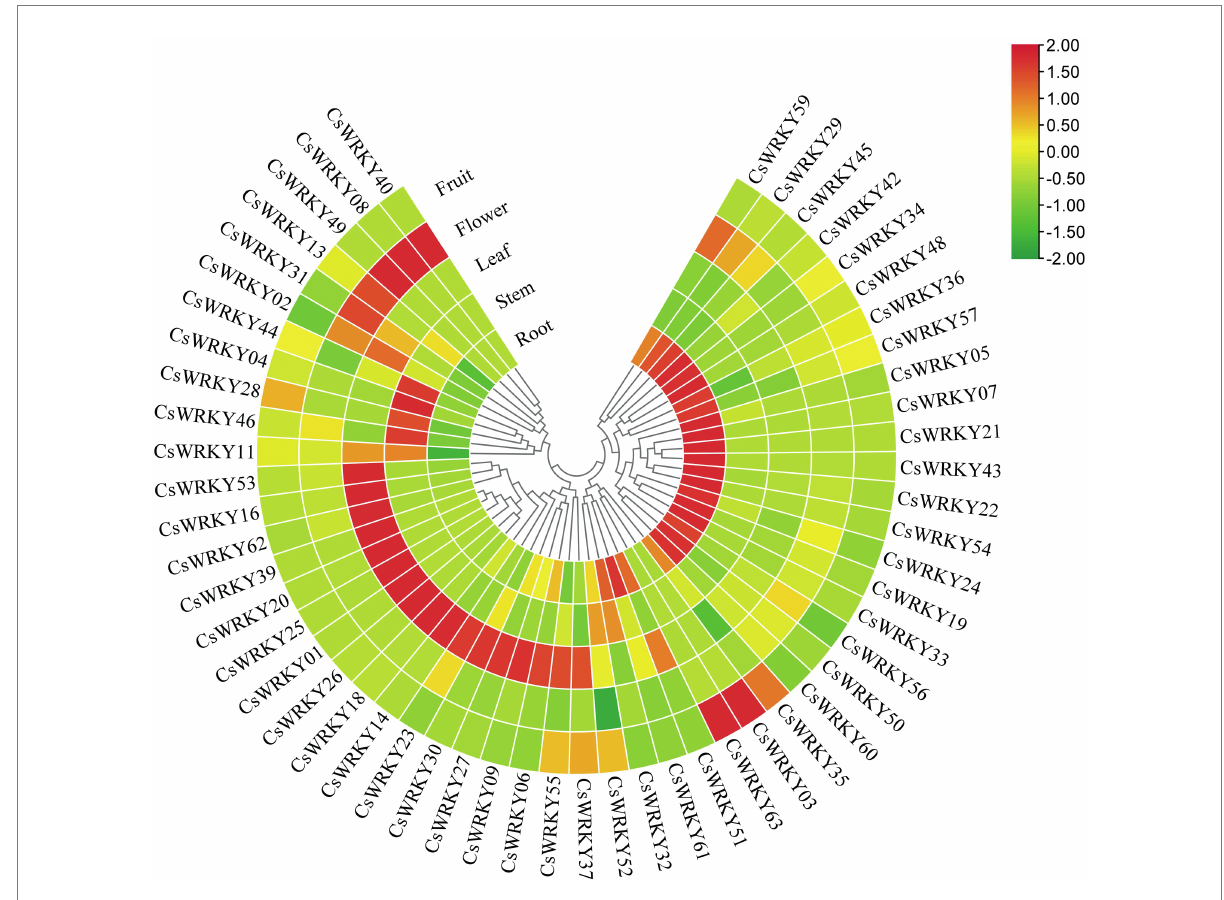
FIGURE 4 Heat map representation and hierarchical clustering of the CsWRKY gene expression profiles in five